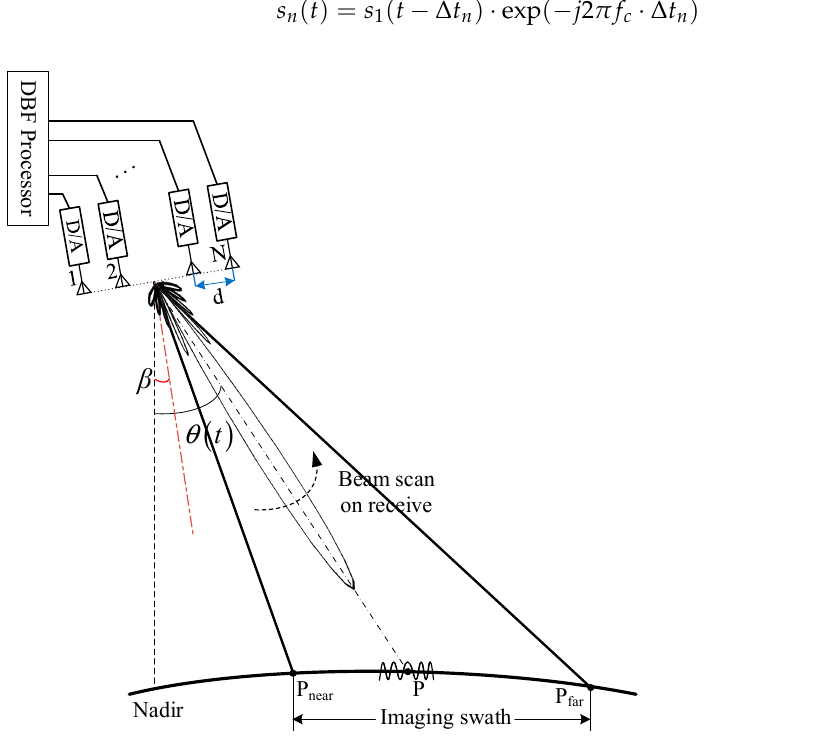
Figure 1. Imaging geometry of DBF SAR with multiple sub-apertures in elevation.